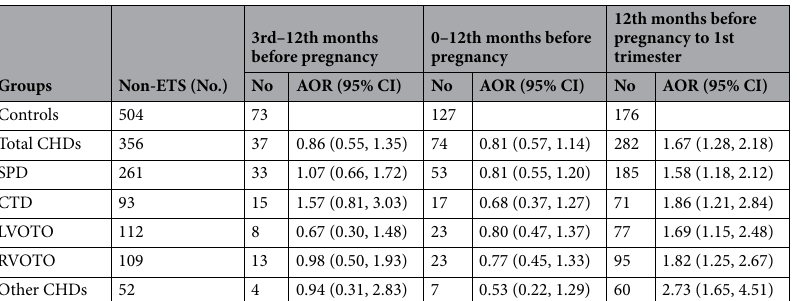
Table 2. Association between maternal ETS and CHDs by CHD subgroup exposure duration. Adjusted by maternal age, maternal education level, residence, congenital anomalies family history, maternal folate intake, maternal HNS exposure, paternal smoking. ETS environmental tobacco smoke, AOR adjusted odds-ratio, CI two-sided confidence interval, SPD septal defects, CTD conotruncal defects, LVOTO left ventricle outflow tract obstruction, RVOTO right ventricle outflow tract obstruction, AVR anomalous venous return.